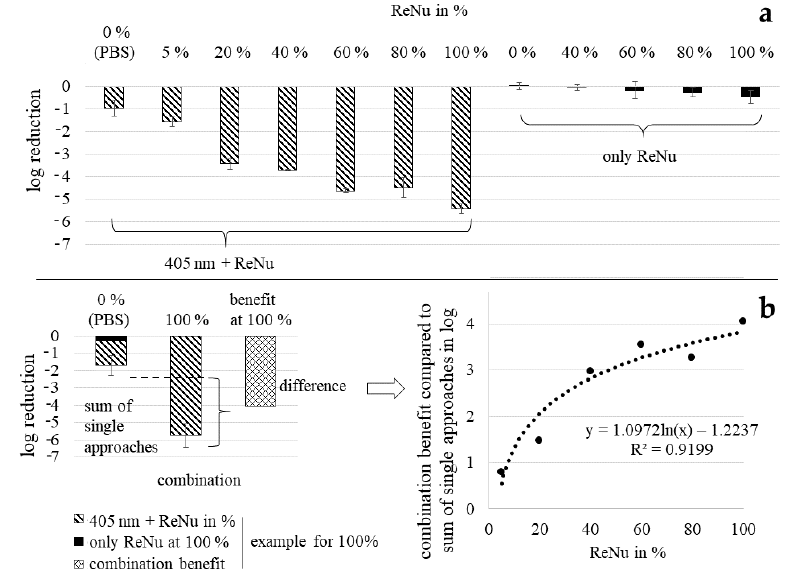
Figure 2. Reduction results with nutrient pads for all combinations tested including single approaches as reference. Error bars indicate the deviation in the three experiments ( a ), Example of “synergy“ calculation as enhancement of the combination over the sum of ReNu Multiplus and light applied separately, and progress of these “synergies“ for different ReNu Multiplus concentrations on P. fluorescens ( b ).